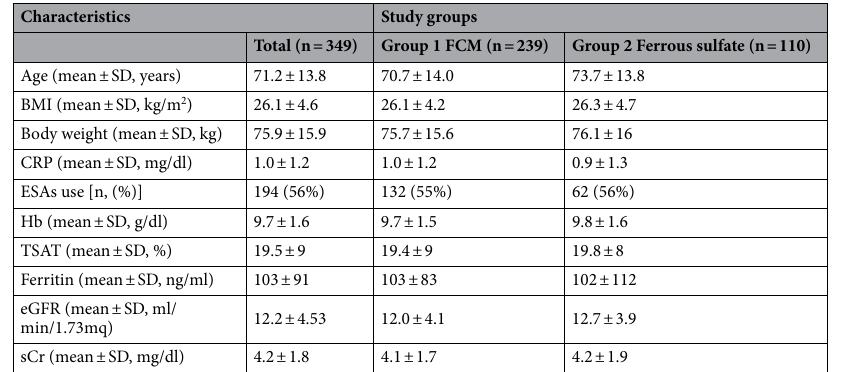
Table 1. Baseline characteristics of patient population.